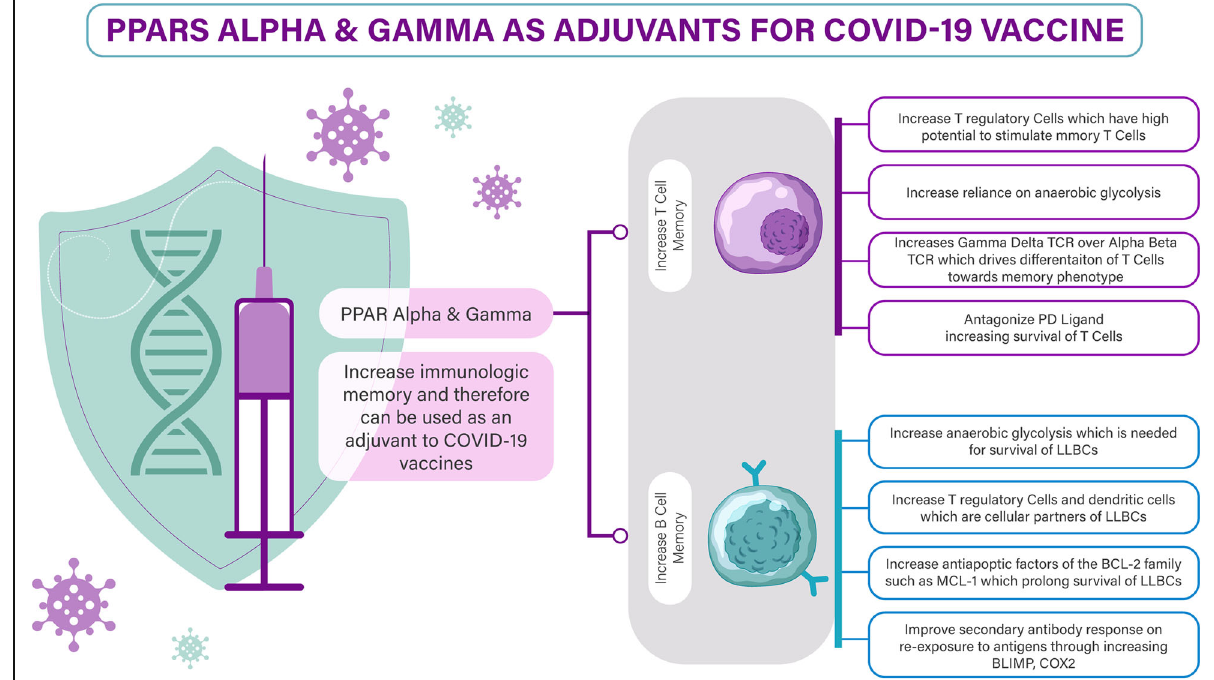
Fig. 1 PPARs alpha and gamma as adjuvants for COVID-19 vaccine. Abbreviations: BCL B cell lymphoma protein, BLIMP B lymphocyte-induced maturation protein, COVID-19 coronavirus disease 2019, COX cyclo-oxygenase, MCL myeloid cell leukemia protein, LLBCs/LLPCs long-lasting B/ plasma cells, PD programmed death, PPAR peroxisome proliferator-activated receptor, TCR T cell